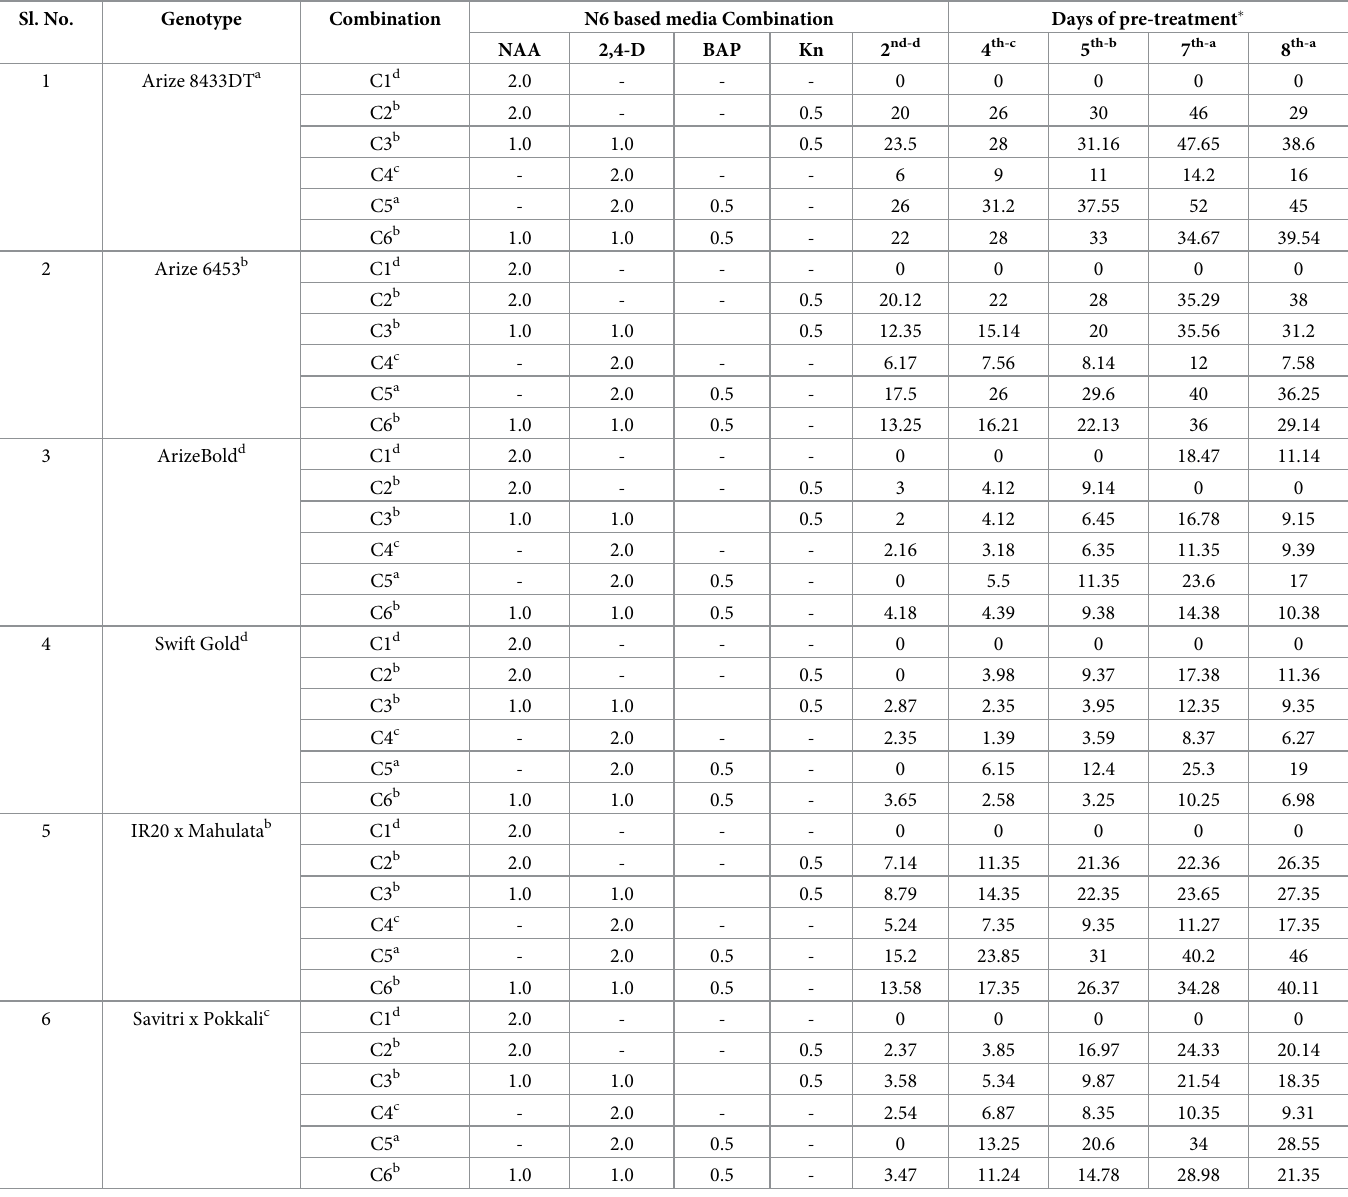
Table 1. Callus induction (%) against days of pre-treatment. Sl.